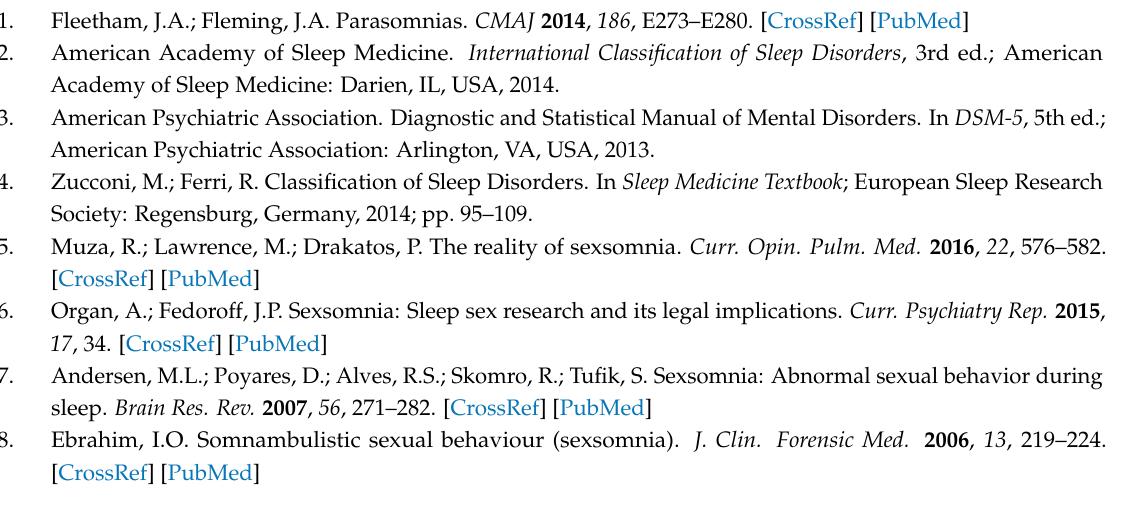
Figure S1: Case 1. Sexsomnia episode on N1/N2 transition with bruxism activity preceding the episode, Figure S2: Case 1. Bruxism episode followed by sexsomnia in REM sleep, Figure S3: Case 1. Myoclonic activity—21 min episode, Figure S4: Case 2. EEG of a single sexsomnia event, Figure S5: Case 2. First two sexsomnia events, Figure S6: Case 2. Whole sexsomnia